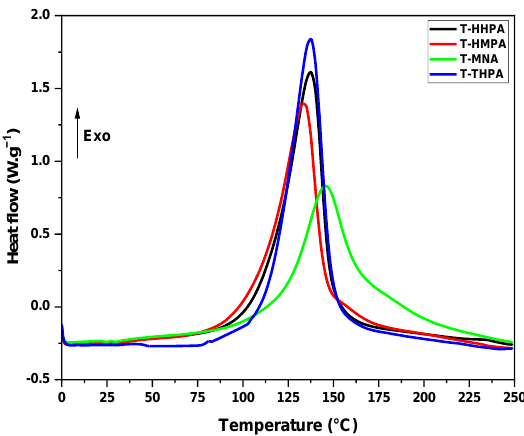
Figure 2. Dynamic DSC curves of the epoxy-anhydride crosslinking formulations under heating at 10 °C·min −1 . Table 2. DSC data of the epoxy-anhydride crosslinking and GC % obtained by solvent extraction method.